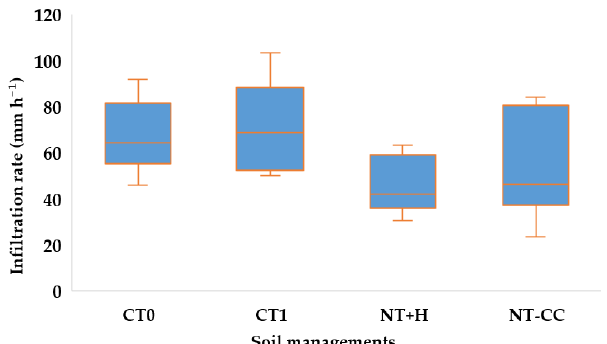
Figure 2. Infiltration rate results (mm h − 1 ) for conventional tillage (CT0; CT1), no tillage with herbicide (NT + H), and no tillage with cover (NT-CC).